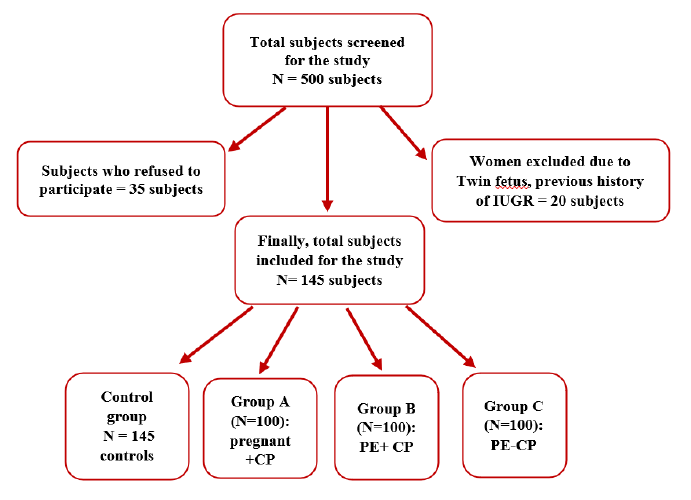
Figure 1. Study flow chart.